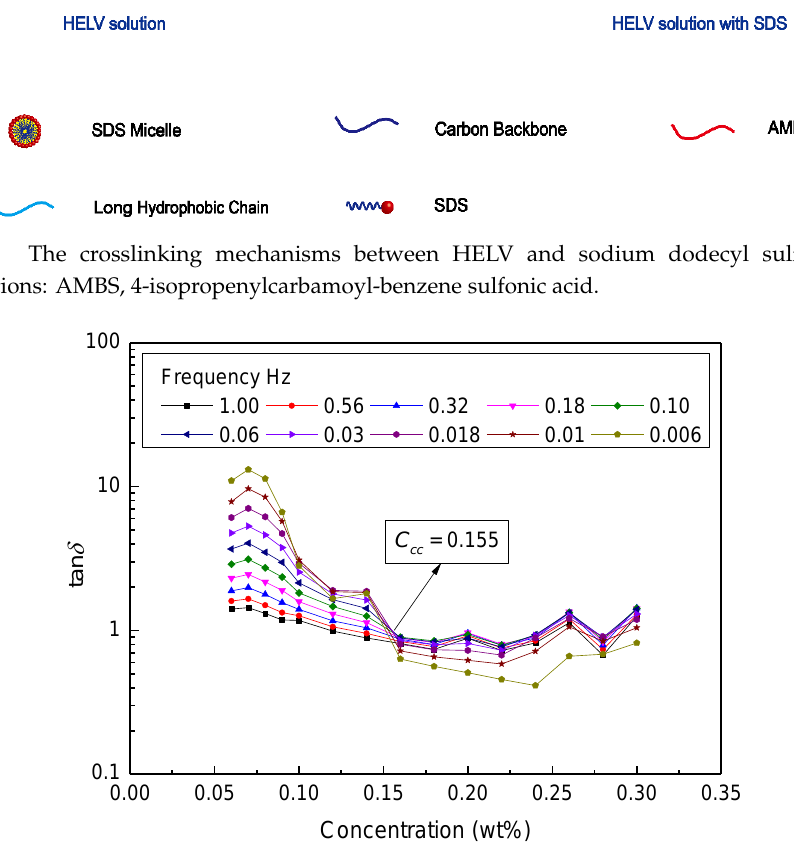
Figure 10. Determining critical crosslinking for the study ′ s HELV solutions.